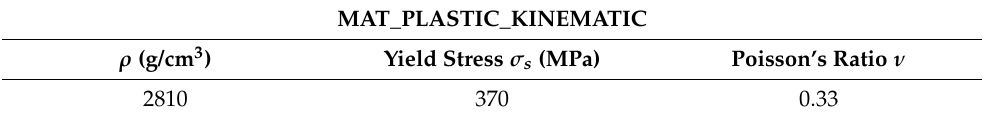
Figure 12. Finite element model of split Hopkinson pressure bar. Table 5. Material model of split Hopkinson pressure